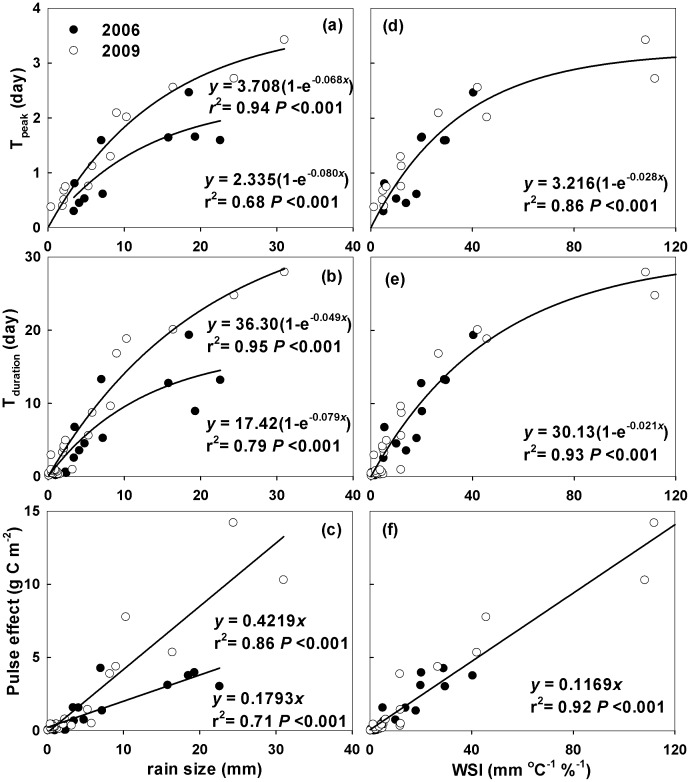
The relationship between dependent variables including the peak time (Tpeak) and the duration (Tduration) of the pulses, and the pulse effects on soil respiration, and independent variables including rain size (a, b, c) and WSI (rain size × the ratio of antecedent soil temperature to soil moisture; d, e, f) in 2006 (solid circle) and 2009 (open circle), respectively.